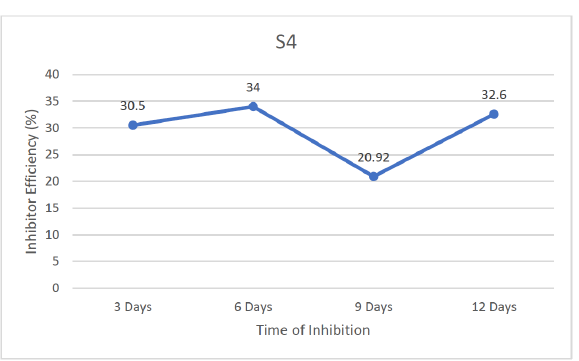
Figure 4: Plot of S4 (Inhibition eflciency versus Time of inhibition (days).